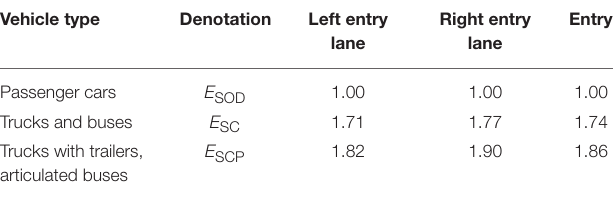
TABLE 8 | Passenger car equivalent factors values for turbo